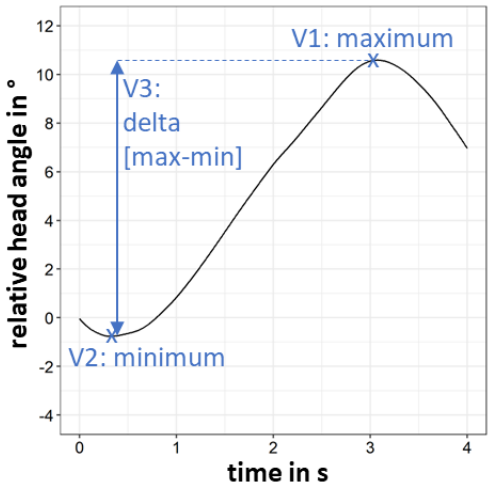
Figure 7. Exemplary plot of the relative head angle during a braking maneuver with an illustration of the four dependent variables of interest (V1 –